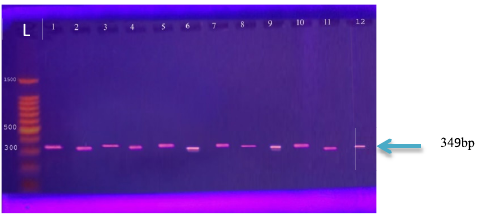
Fig. 2. Gel electrophoresis for detecting MBL gene amplicon product were separated by gel electrophoresis in an 1.5% agarose, at 70 volt for 45 min. lane: 1,2,3,4,5, 6 healthy control., lane 7,8,9,10,11,12 patients, 1500bp marker (Ladder). The size product is 349 bp Table 3. Genotype distribution of -54 G/A polymorphism in promotor region in MBL gene with preterm labor